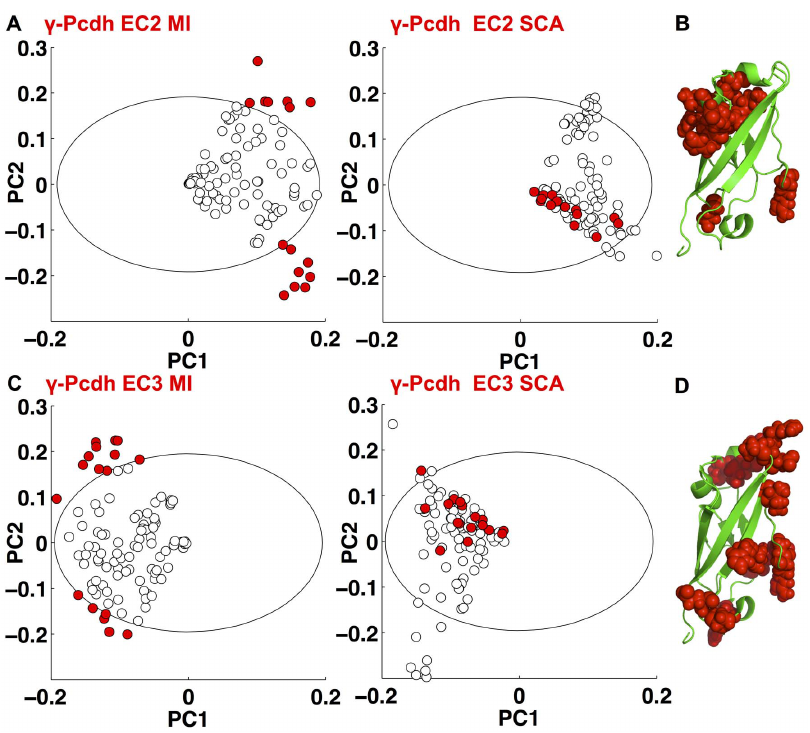
Figure 6. A) PCA of the correlation matrix produced by (left) w var and MI and (right) w cons and SCA , applied to the Pcdh- ª EC2 ij ij alignment. B) Residues identified and colored as in (A) mapped onto the crystal structure 1WUZ of Pcdh- a [33]. C) PCA of the correlation matrix , and (right) w cons and SCA applied to the Pcdh- c EC3 alignment. D) Residues identified and colored as in (B) mapped produced by (left) w var and MI ij ij onto the crystal structure 1WUZ of Pcdh- a [33].